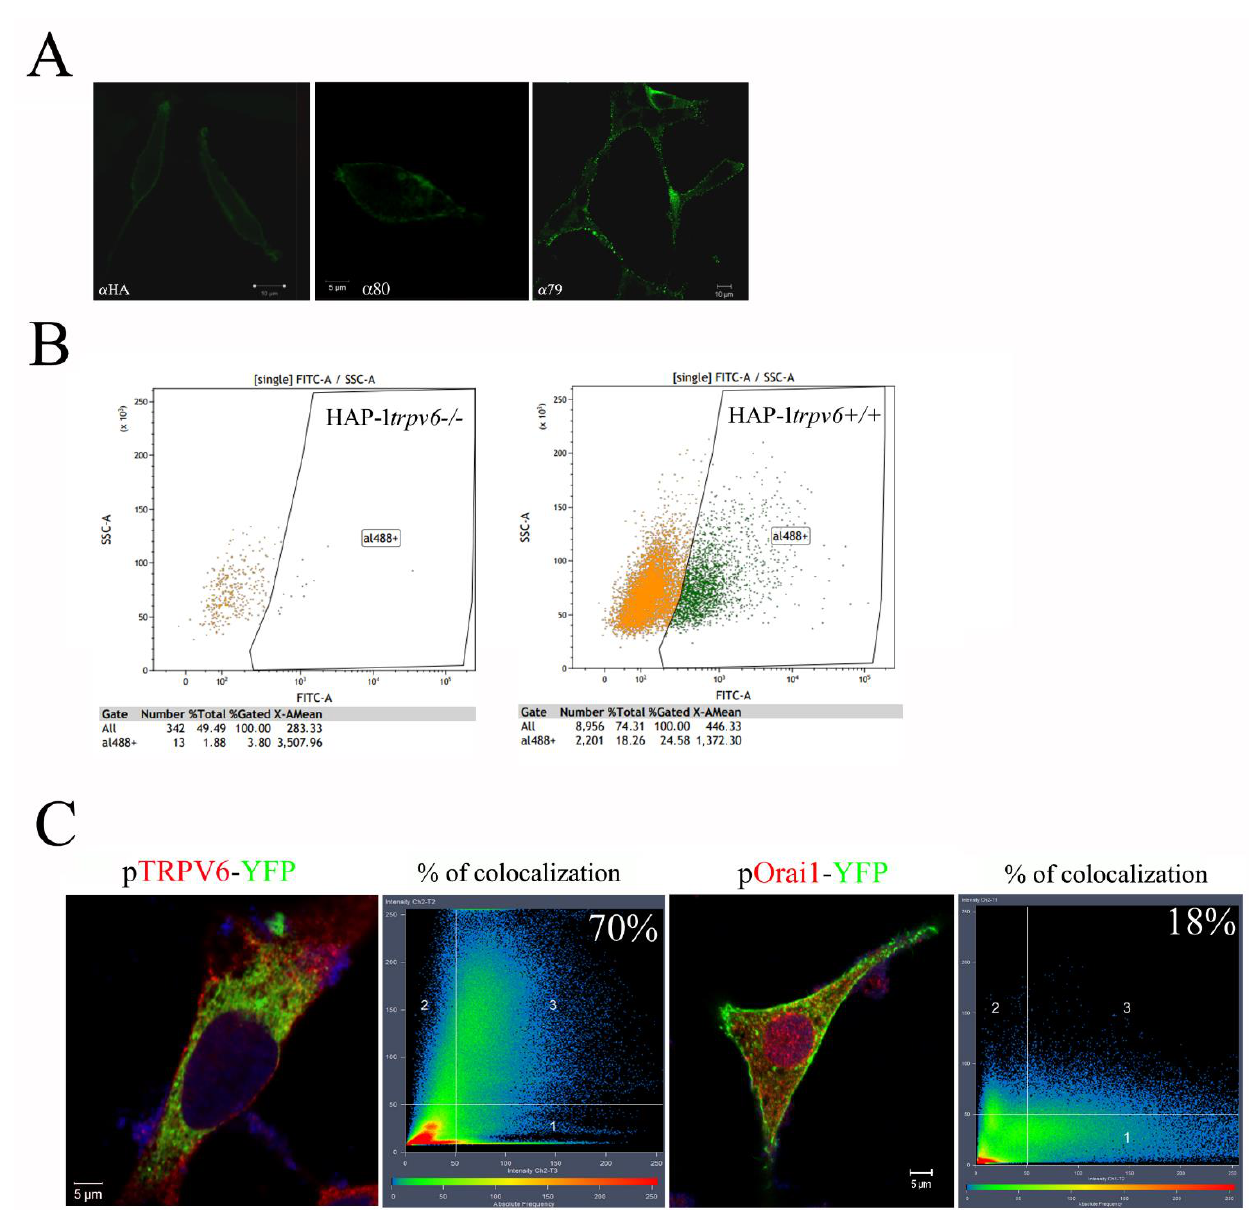
Figure 5. rb79 in plasma membrane TRPV6 staining. ( A ), Immunofluorescence signal (secondary antibody AlexaFluor-488, green) from the 3.5% paraformaldehyde-fixed non-permeabilized LNCaP cells treated with the following primary antibodies: rabbit polyclonal anti-HA tag antibody, rabbit polyclonal anti-TRPV6 antibody rb80 (N-terminus epitope), and rb79 (X-loop). ( B ), TRPV6 surface expression using rb79 in non-permeabilized HAP-1 trpv6−/− versus HAP-1 trpv6+/+ cells studied using a FACScan flow cytometer (Becton – Dickinson, San Jose, CA, USA). ( C ), Immunofluorescence signal from the 3.5% paraformaldehyde-fixed, saponin-permeabilized LNCaP cells transfected with either pTRPV6-YFP (left) or pOrai1-YFP (right) plasmids. Both conditions were treated with rb79 followed by the AlexaFluor546 secondary antibody (red). The mean overlapping coefficient between red (TRPV6) and green (YFP) signals is shown as % in the right corner. The additional experiment using FACS has been performed where cells were not permeabilized with Triton X-100. HAP1 trpv6 −/− cell model has been used as compared to HAP1 trpv6+/+ cells (Figure 5B). HAP1 trpv6+/+ cells seem to contain 24.58% TRPV6 positive cells at the plasma membrane versus 3.8% in HAP1 trpv6 −/− .